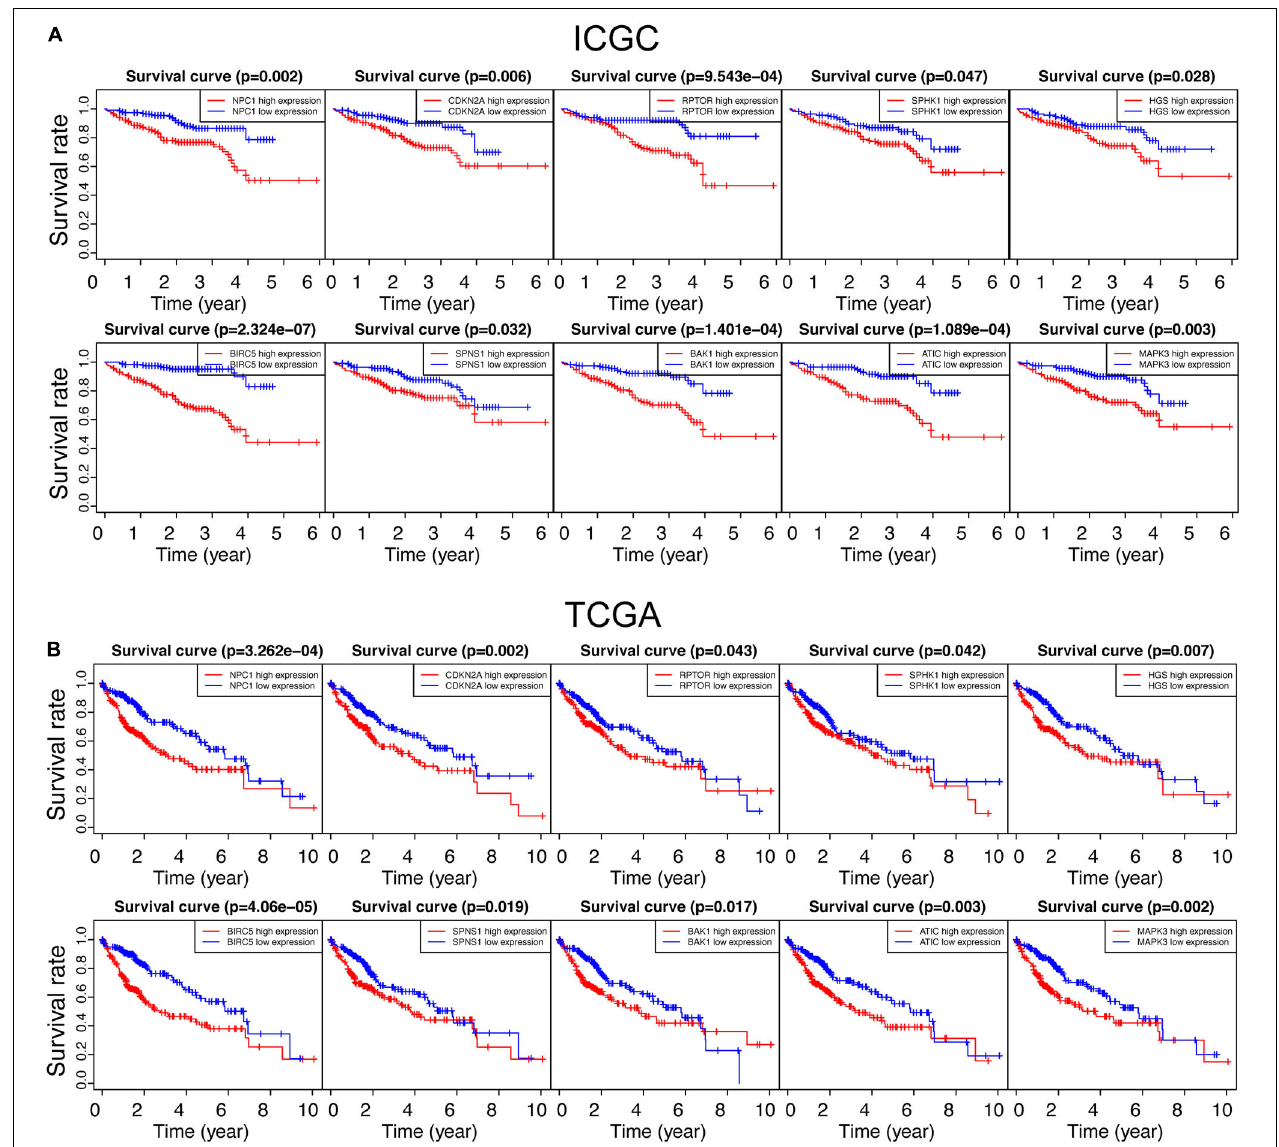
FIGURE 4 | Survival analysis of all autophagy-related DEGs in the ICGC and TCGA databases. “ p < 0.05” was considered significant, and only 10 overlapped genes in ICGC and TCGA are presented in panels (A,B) ,